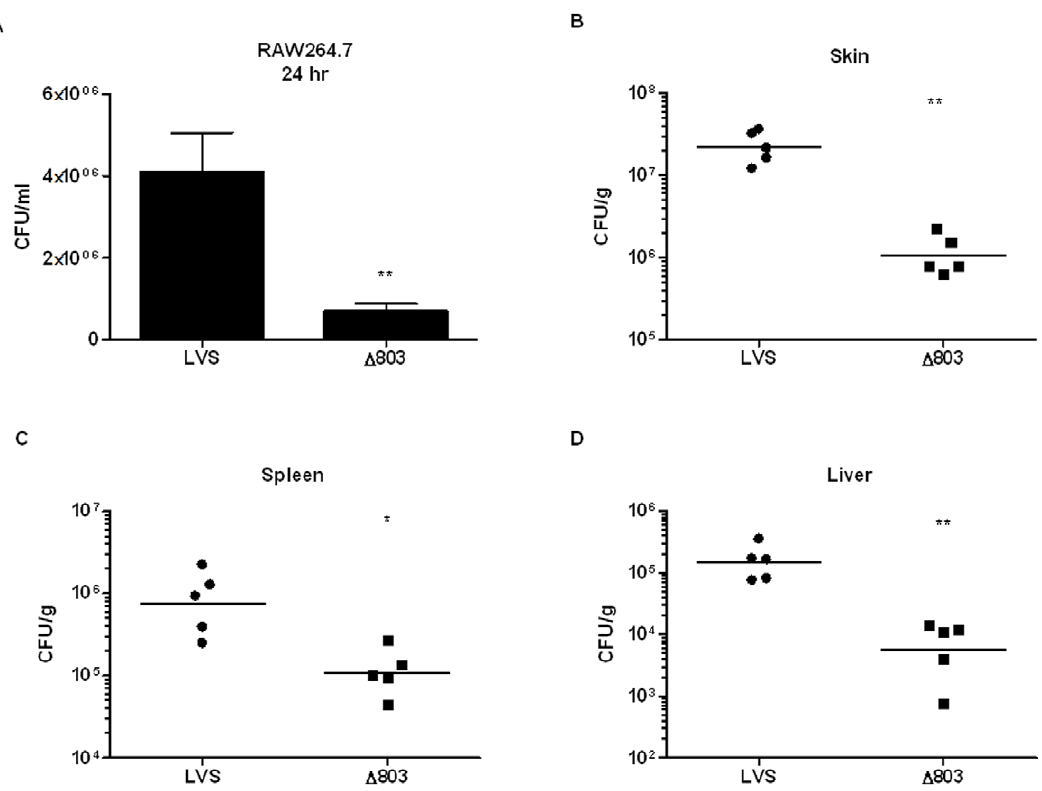
Figure 9. FTL_0803 is important for LVS replication in macrophages and mice. (A) RAW264.7 macrophages were infected with a 20:1 MOI of wild-type LVSand the FTL_0803 mutant( D 803). Twenty-four hours post-infection, intracellular CFUs were determined for both strains. Bars represent the mean and error bars represent the standard deviation (n=3). (B–D) Mice were subcutaneously infected with 2 6 10 5 CFU of either wild-type F. holarctica LVS (WT) or the FTL_0803 mutant ( D 803). Seventy-two hours after infection, organs were harvested, plated, and CFU were enumerated 48 hours later for the skin at the site of infection (B), spleen (C), and liver (D). Bars represent the geometric mean from each group of mice (n=5). Data shown is representative of two independent experiments. Asterisks indicate significance as compared to wild-type. (*) p , 0.05, (**) p , 0.005.